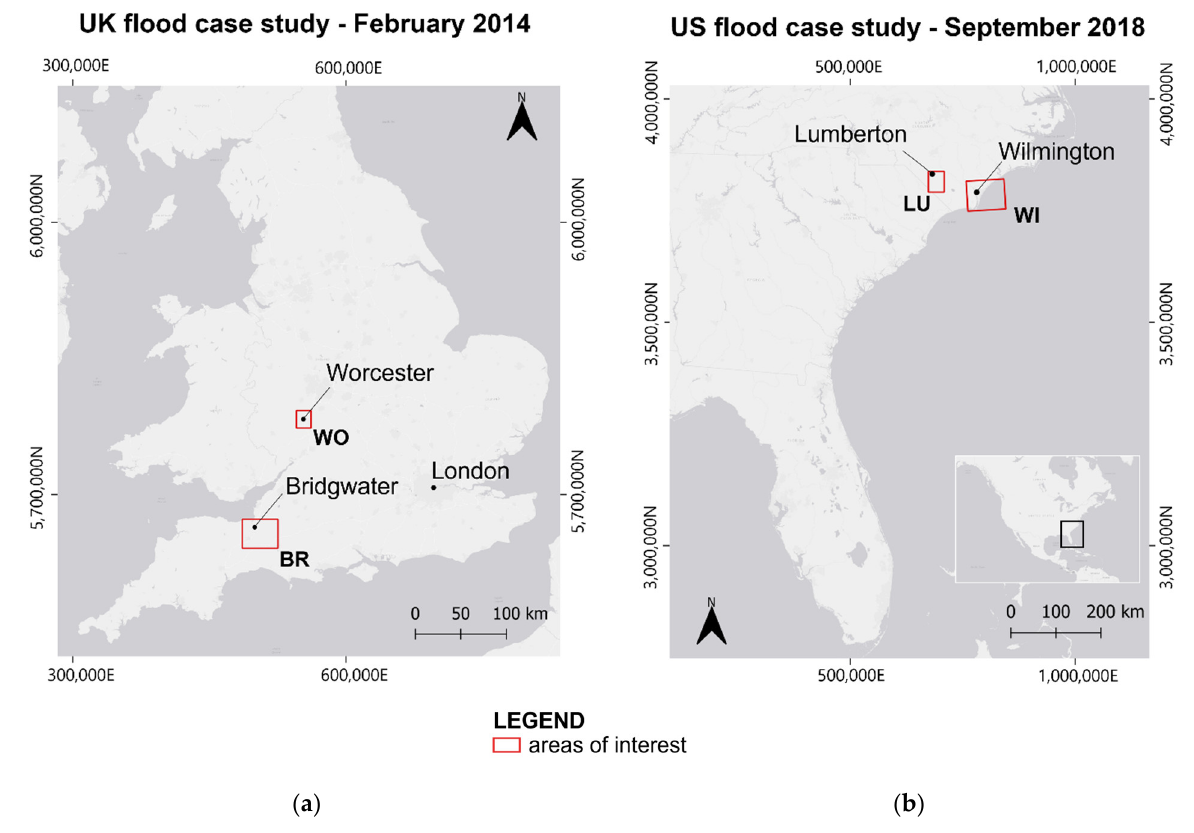
Figure 2. Overview of the areas of interest for the UK flood case study ( a ) and US flood case study ( b ). CRS: WGS84/UTM zone 30 N ( a ), WGS84/UTM zone 17 N ( b ). Basemap data: Esri Gray (light) © Esri.